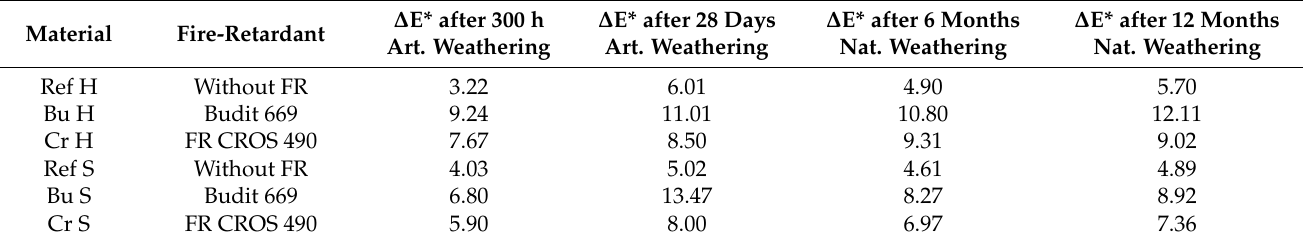
Table 6. Color ( ∆ E*) change of wheat straw-based, fire-retarded, co-extruded profiles after artificial and natural weathering according to DIN EN ISO 4892-2 (cycle 2) and EN 927-3. H: hollow core; S: solid. For composition of the formulations, see Materials and